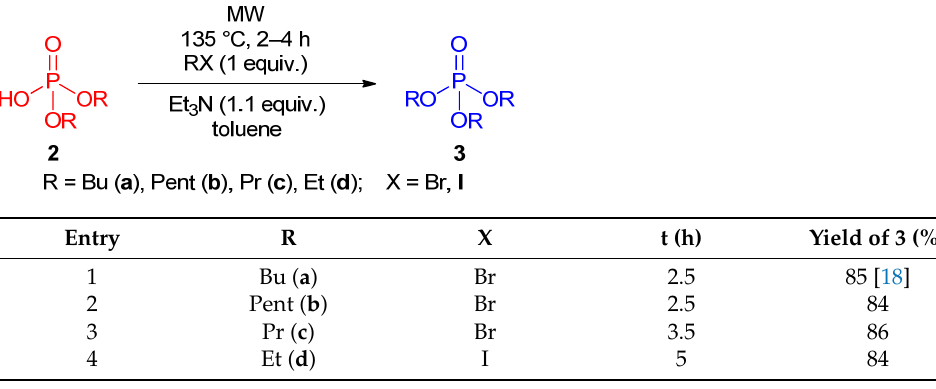
Table 3. Alkylating esterification of dialkylphosphates ( 2 ) under MW conditions.